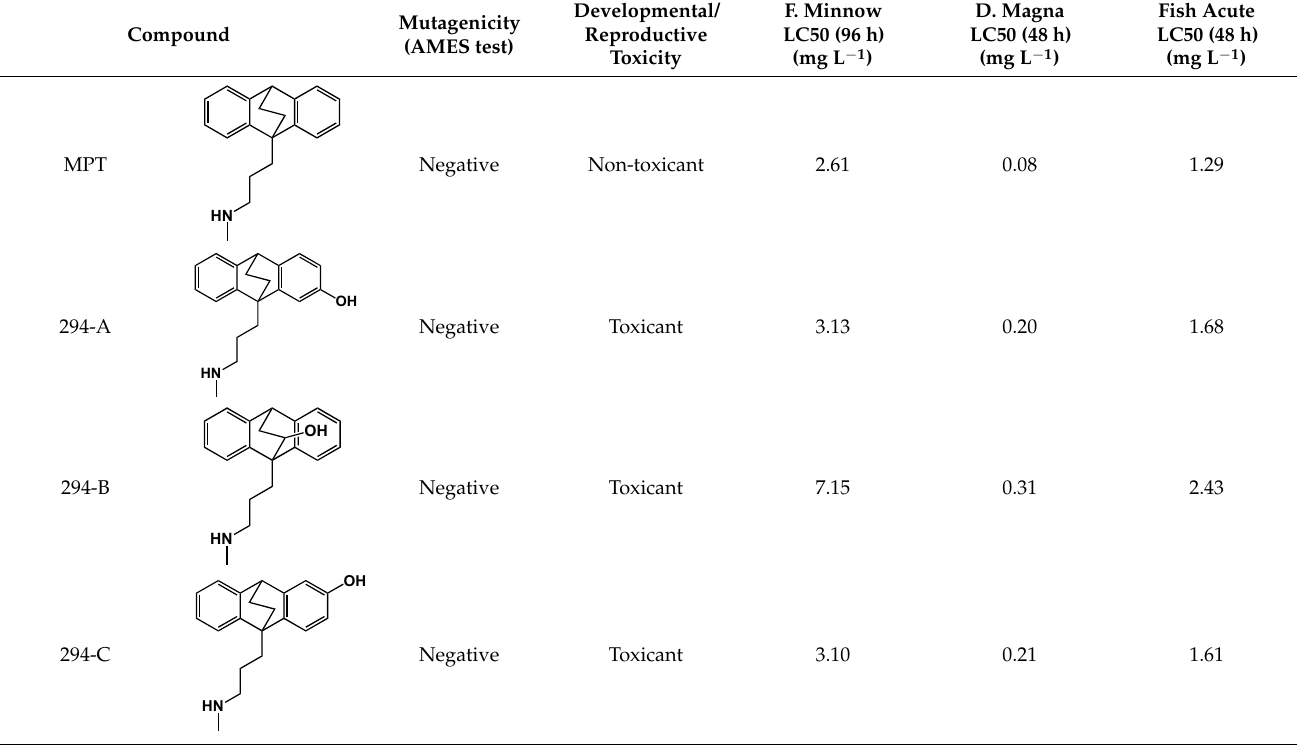
Table 2. Toxicity values estimated by the VEGA software for maprotiline and the main degradation products . Compound